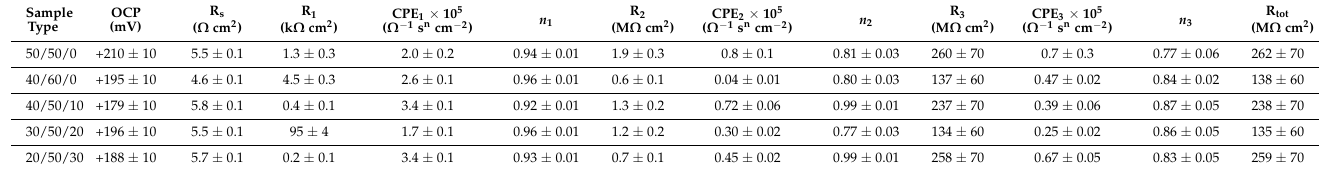
Table 3. Best fitting EEC parameter values for EIS spectra of samples nitrided at 380 ◦ C with different treatment atmospheres (indicated as ratio of the volume percent of N 2 to H 2 to Ar content), tested at the respective OCP (model: inset B in Figure